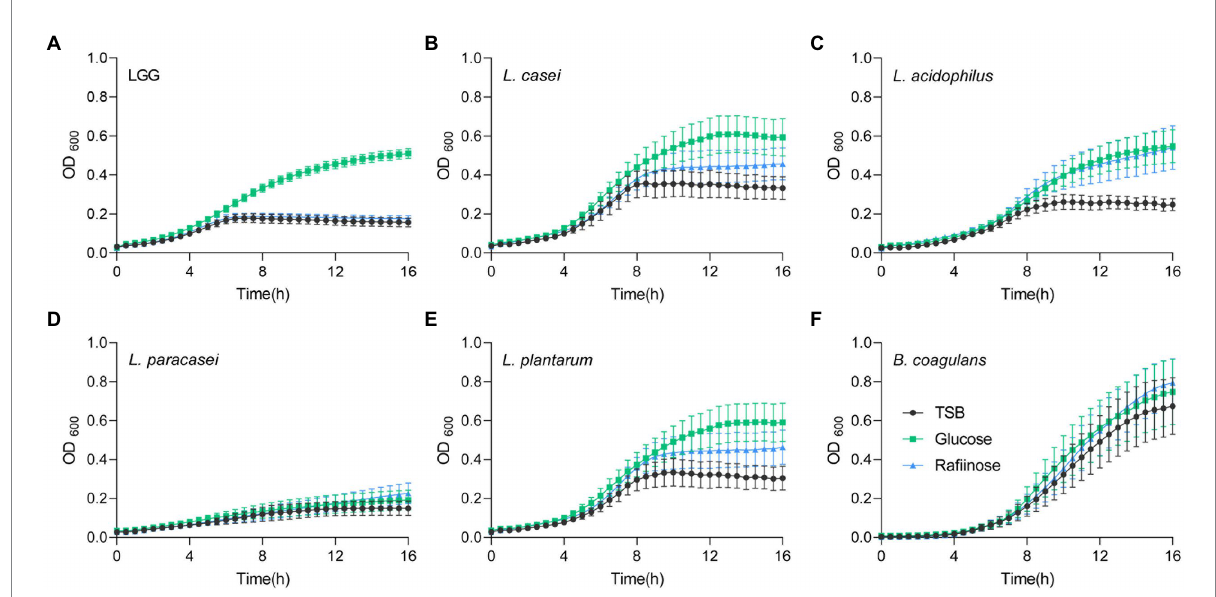
FIGURE 1 Heterogeneous alterations in planktonic growth of LAB strains during glucose utilization. Planktonic growth of the indicated species (A) LGG; (B) L. casei ; (C) L. acidophilus ; (D) L. paracasei ; (E) L. plantarum , and (F) B. coagulans in TSB medium (control) either supplemented or not with glucose (1% W/V) and raffinose (1% W/V). Graphs represent mean ± SEM from six independent experiments ( n =